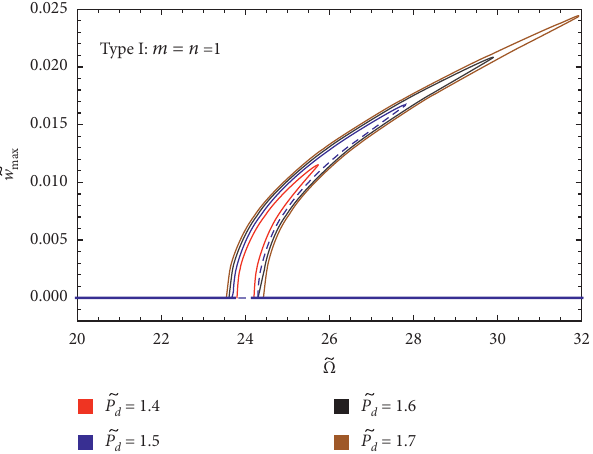
Figure 6: The effect of 􏽥 P d on the transverse motion of type I BDFG beam with m � n � 1, L / h � 20, 􏽥 c d � 􏽥 c r � 0 . 05, and P s � 5.